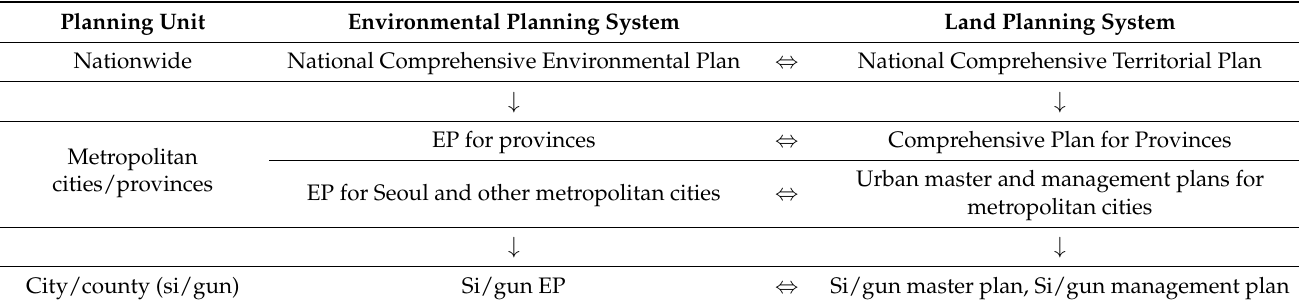
Table 1. Linkage systems between environmental and land planning. Drawn according to the Joint Ordinance for Integrated Management of Environmental Plans and Land Plans